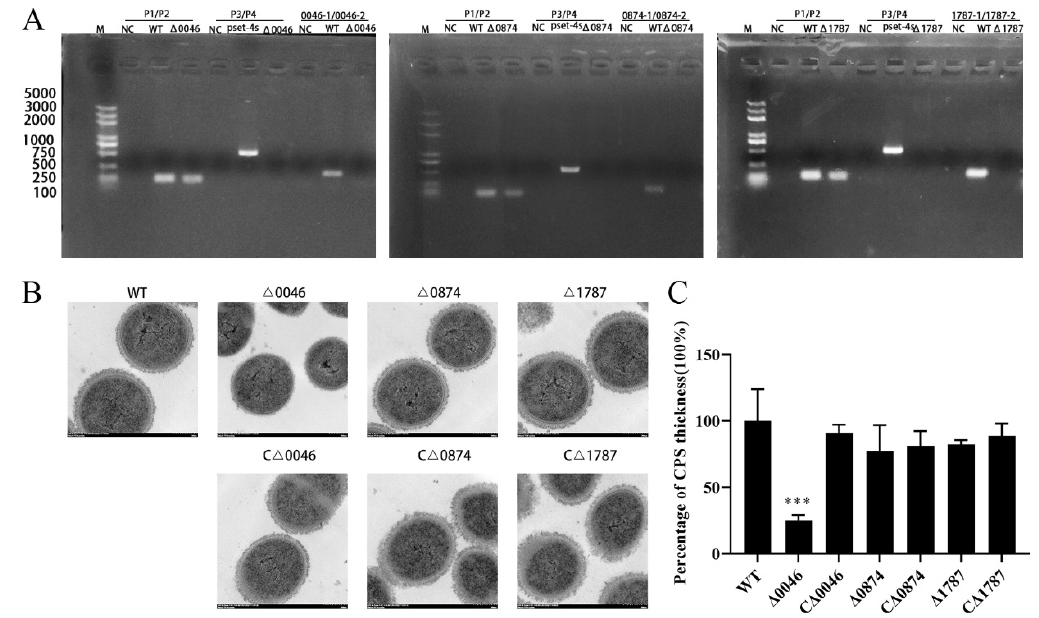
Figure 2. Construction of Streptococcus suis mutants and identification of phenotypes. ( A ) Confirmation of mutants by PCR using the primer pairs P1/P2 (to detect the gdh gene), P3/P4 (to detect the pSET4s vector), 0046-1/0046-2 (to detect the SSUSC84_0046 gene), and 0874-1/0874-2 (to detect the SSUSC84_0874 gene), 1787-1/1787-2 (to detect the SSUSC84_1787 gene). ( B ) The capsules of WT, ∆ 0046 , C ∆ 0046 , ∆ 0874 , C ∆ 0874 , ∆ 1787 and C ∆ 1787 strains were detected by transmission electron microscopy (×20,000). ( C ) Image-pro Plus was used to measure and calculate the average capsular thickness. *** p < 0.001.